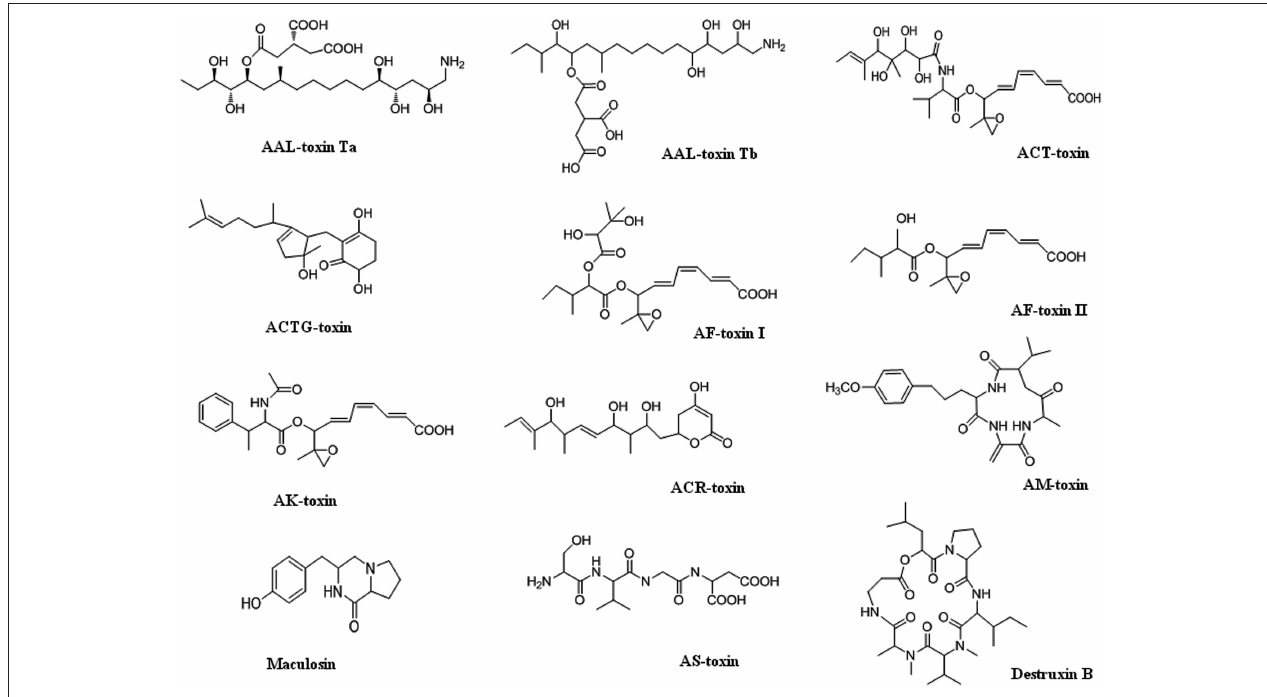
FIGURE 1 | Chemical structures of HSTs produced by Alternaria